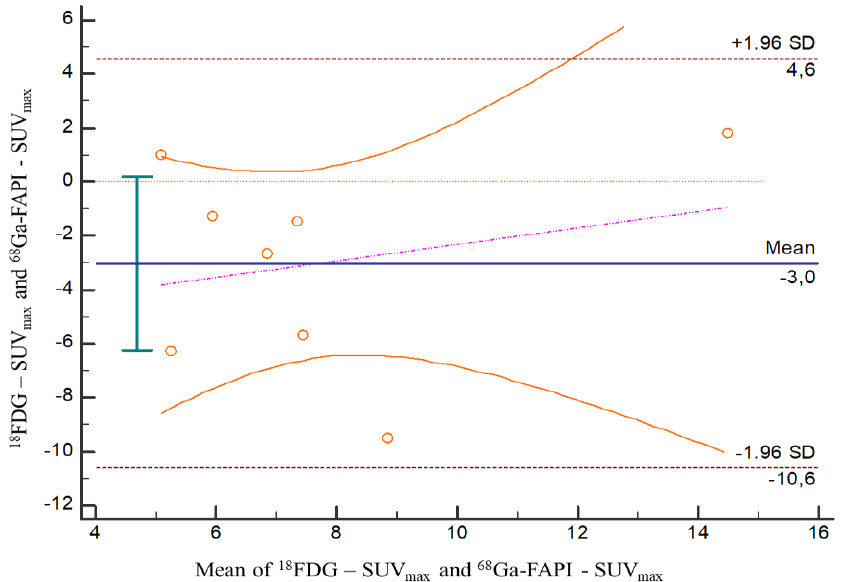
Figure 3. Bland–Altman plot for comparison between SUV max values of bone lesions detected in [18F]FDG PET/CT and [68Ga]FAPI PET/CT. Mean SUV max value was 6.15 ± 3.97 ( n = 8) in [18F]FDG and 9.30 ± 3.22 ( n = 10) in [68Ga]FAPI. There was no statistically significant difference between SUV max values of bone lesions detected in both modalities ( p = 0.081).